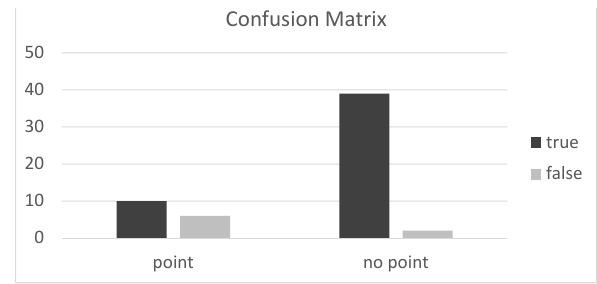
Figure 10. Confusion matrix of Random Tree classifier - dark areas are correctly classified